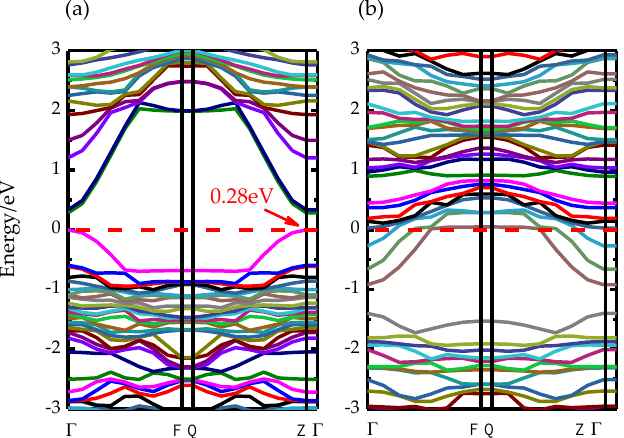
Figure 2. The band structures of relaxed ( a ) 1I-BiOI/TiO 2 , ( b ) BiO-BiOI/TiO 2 heterojunction. Red dashed line represents the Fermi level.